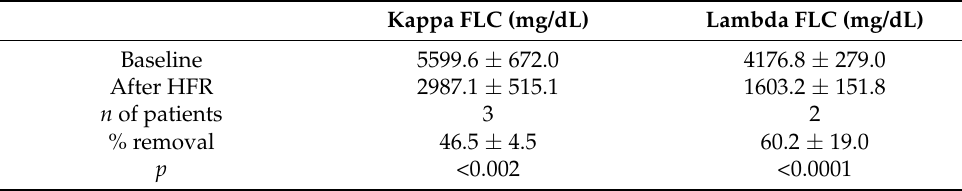
Table 4. Free light chain (FLCs) levels before and after 5 HFR sessions in 3 pts with κ LC and 2 pts with λ LC nephropathies. Post-treatment levels are corrected for ultrafiltration. Two patients recovered from HD in the κ LC group vs. 1 λ LC patient. Data are averaged from 5 HFR sessions in each individual patient, pre-(baseline), and post-(after) 4 h HFR sessions ± SEM, one-way ANOVA on paired observations. Kappa FLC (mg/dL) Lambda FLC (mg/dL) Baseline 5599.6 ± 672.0 4176.8 ± 279.0 2987.1 ± 515.1 1603.2 ±